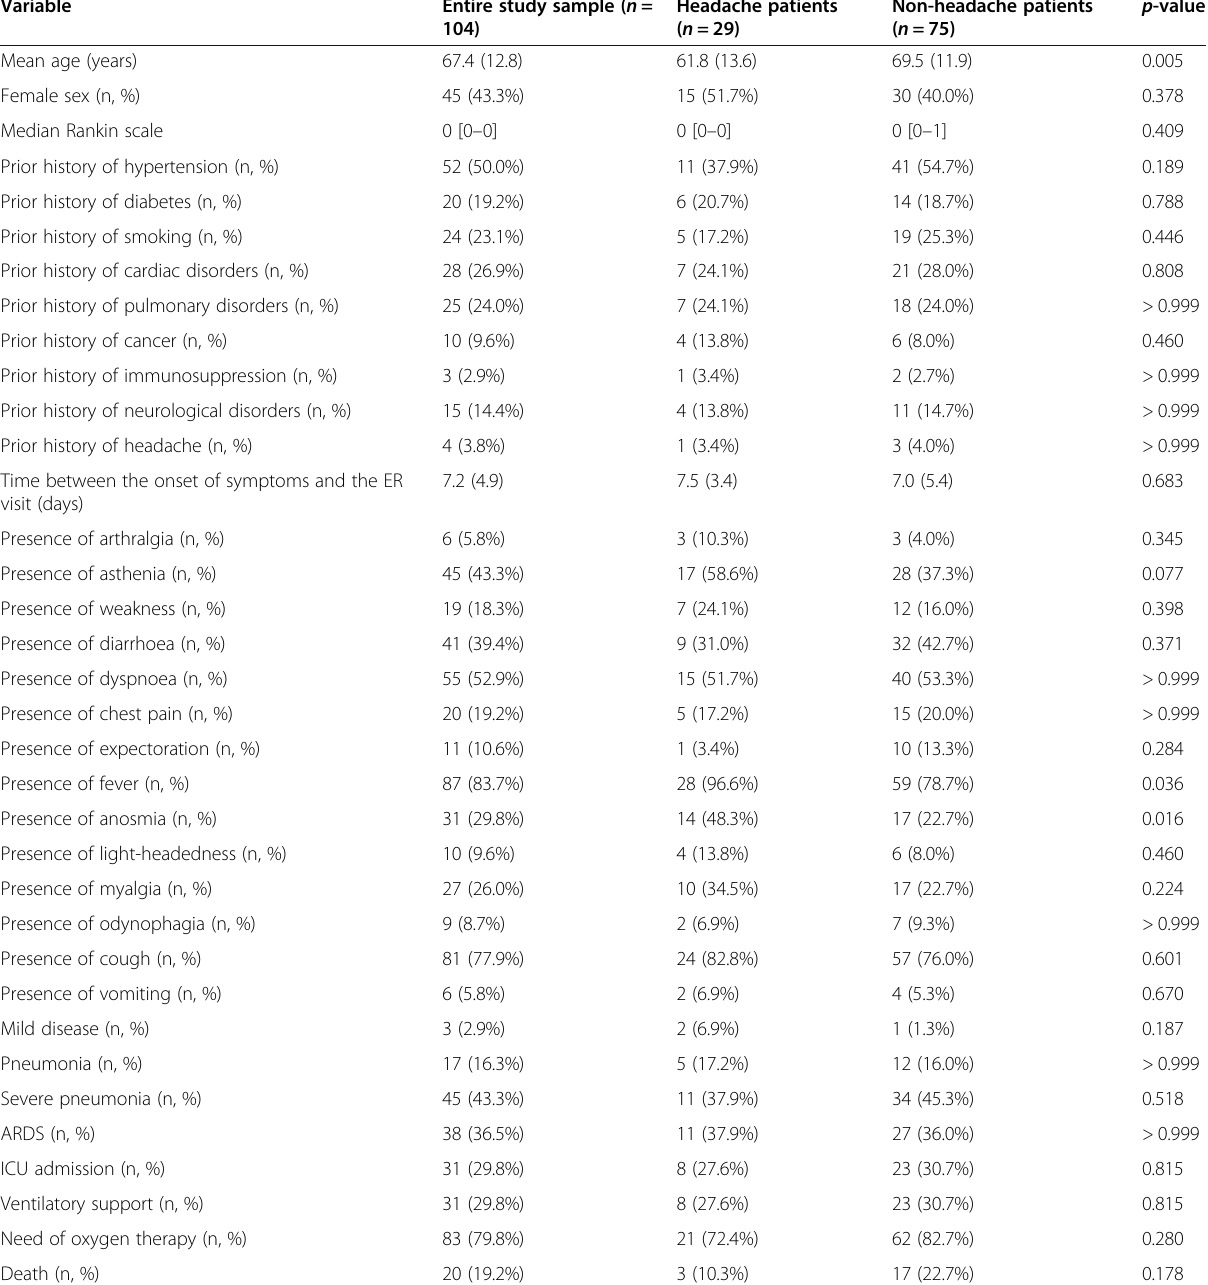
Table 1 Demographic, clinical and outcome